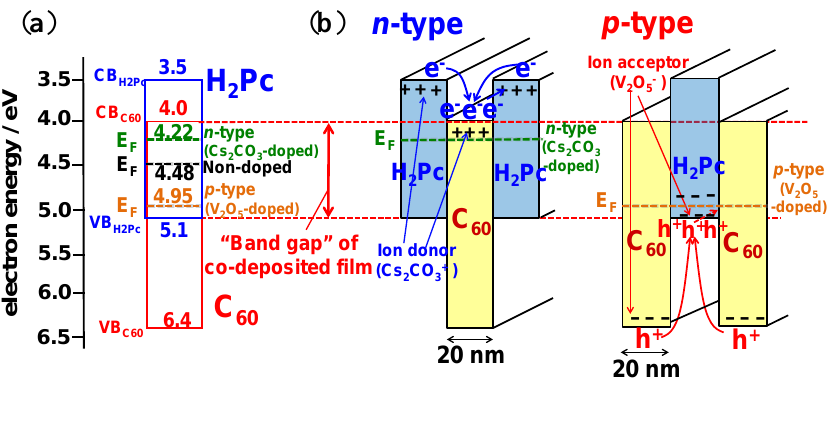
Figure 23. ( a ) pn -control of H within the “bandgap of the co-deposited film”. ( b ) Mechanism of n - and p -type